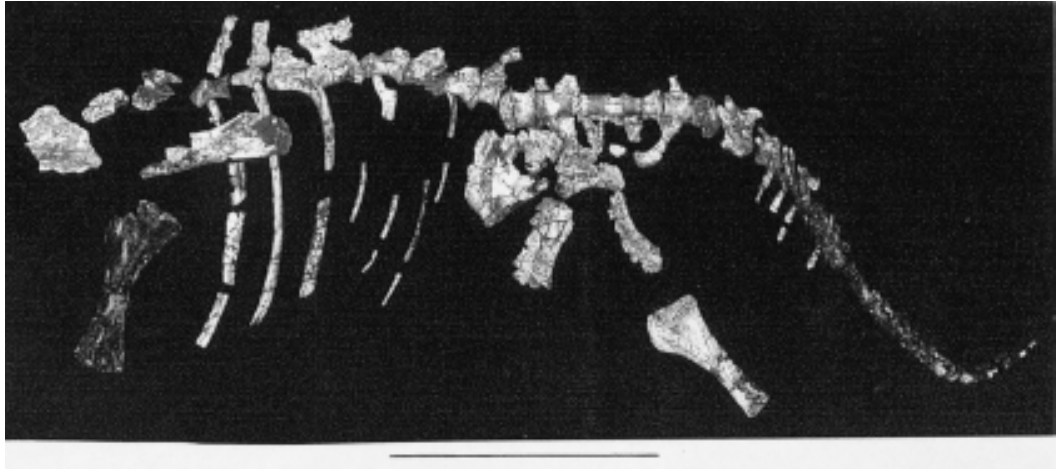
Fig. 10 – Preserved skeleton of Gondwanatitan faustoi , a titanosaurid sauropod from the Bauru Group (Upper Cretaceous) of São Paulo. This is the most complete sauropod skeleton found in Brazil so